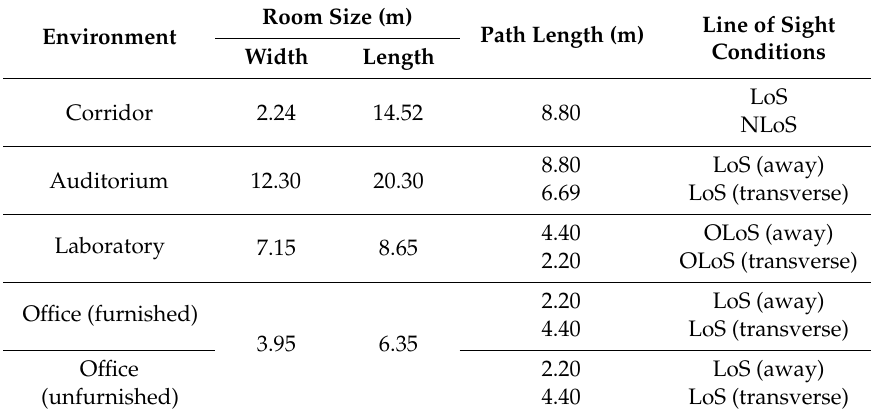
Table 1. Summary of measurement environments in di ff erent line of sight conditions: line of sight (LoS), obstructed line of sight (OLoS) and non-line of sight